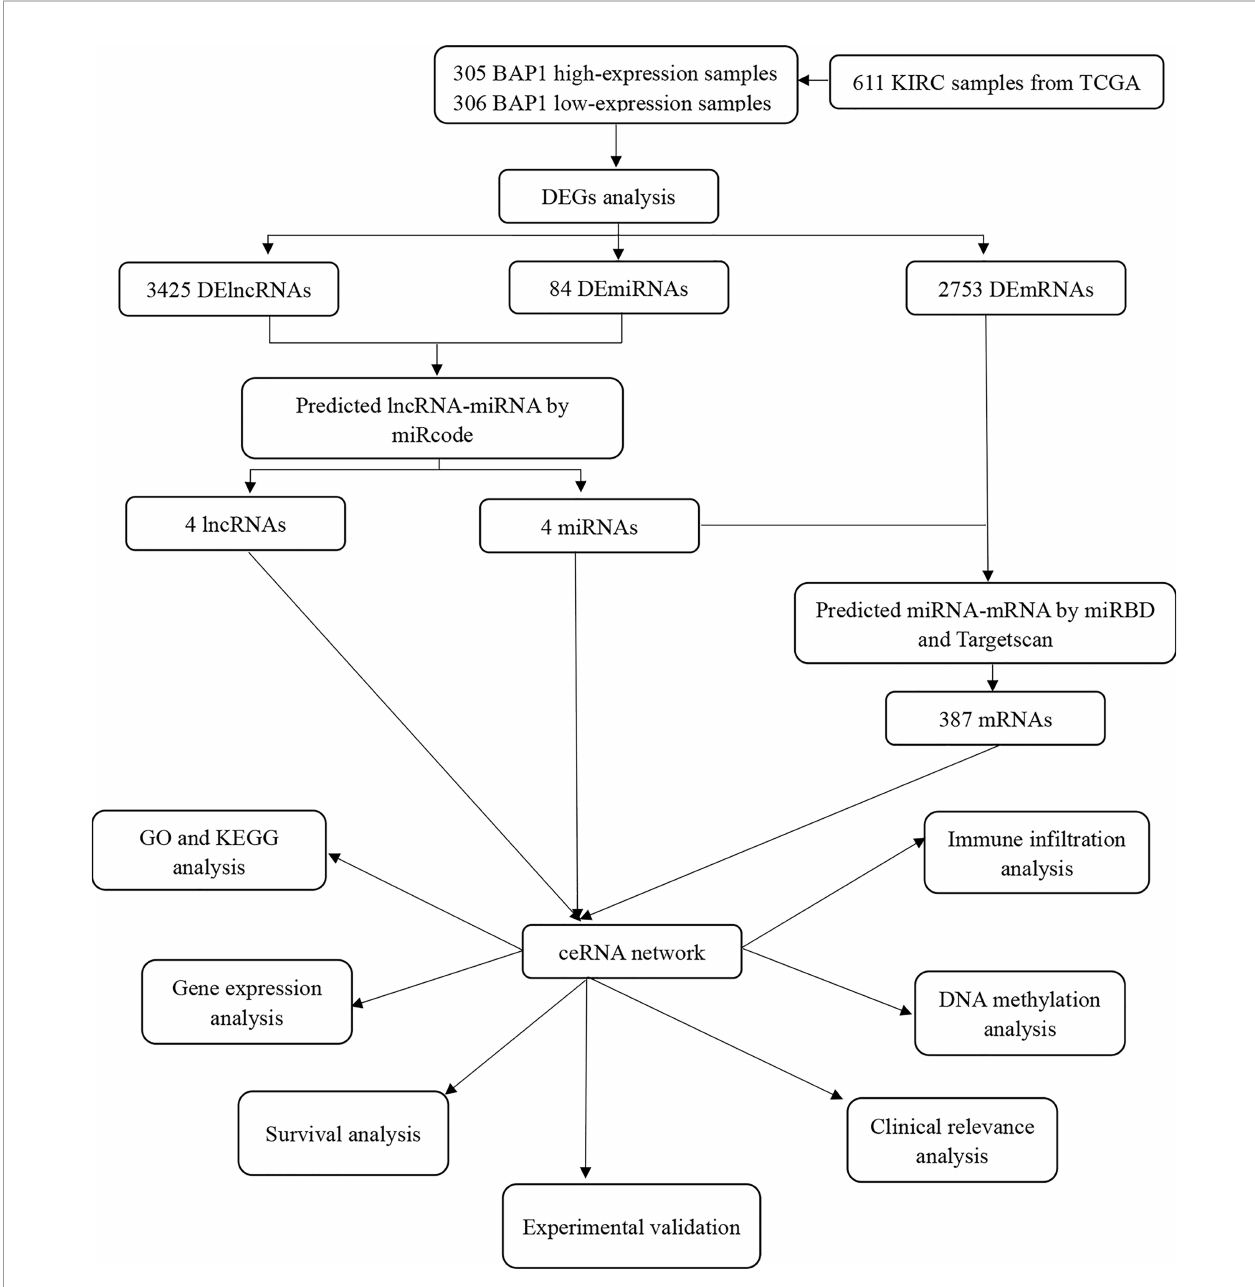
FIGURE 1 | Flow diagramm of ceRNA construction and